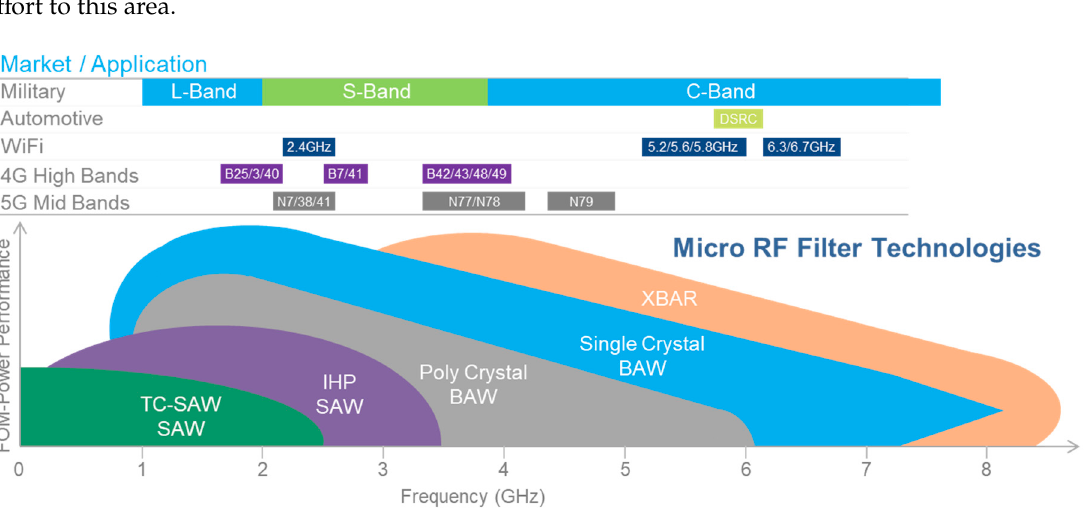
Figure 1. Market application and band allocation of radio frequency (RF) filter technologies [5].